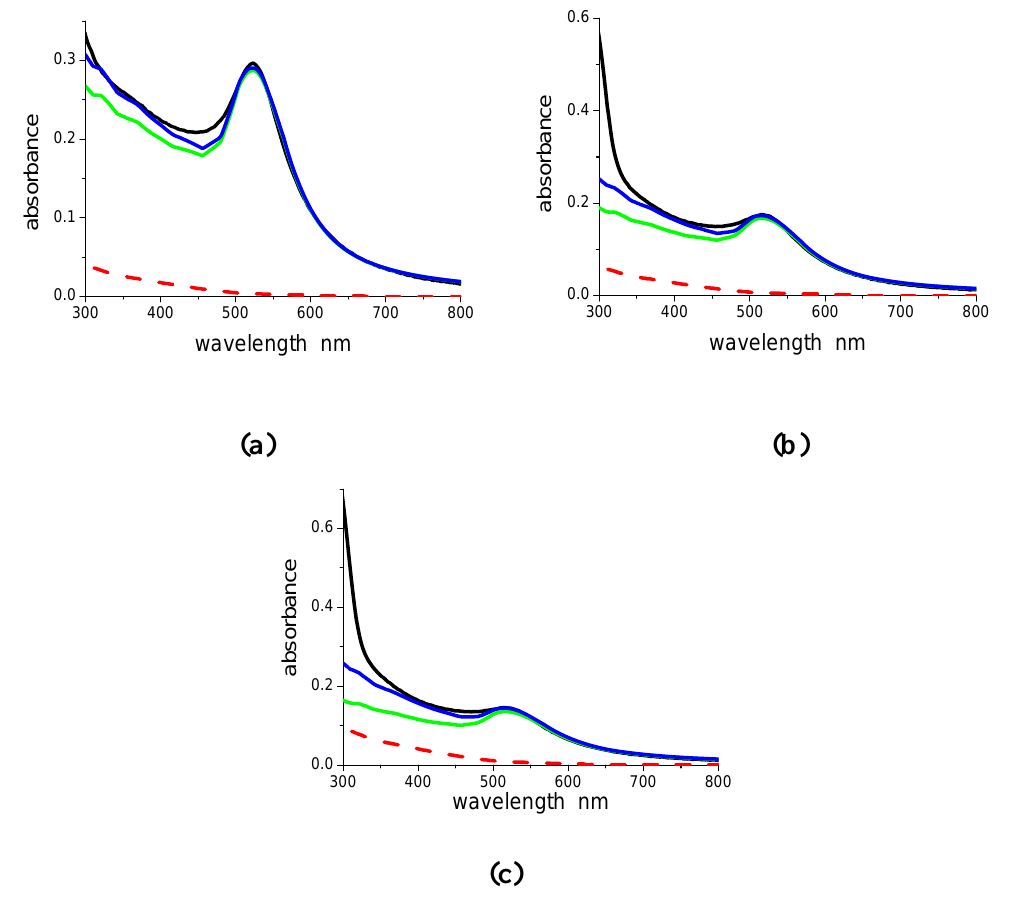
Figure 5. Simulations of UV-Vis spectra of PAMAM G5-capped AuNPs produced with 1,064 nm, 15 mJ (a) and post-irradiated with 532 nm, 5 mJ, 9,600 shots (b), or with 532 nm, 10 mJ, 4,800 shots (c). Black curves: experimental spectra; blue curves: complete fit; green curves: Mie’s fit without the contribution of sub-nm clusters; dashed red curves: contribution of sub-nm clusters. OPL = 1